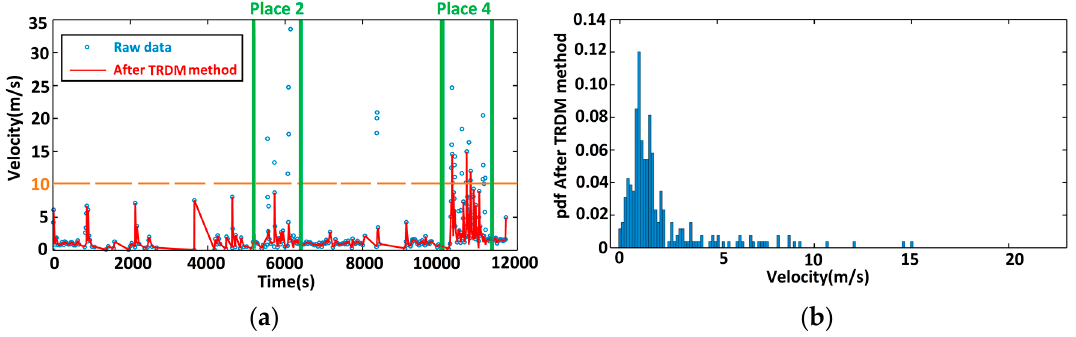
Figure 6. Walking velocity of the volunteer after TRDM method. ( a ) Velocity before and after cleaning; ( b ) Velocity probability distribution after TRDM method. Table 1. Statistical parameters of velocity of comparative results.